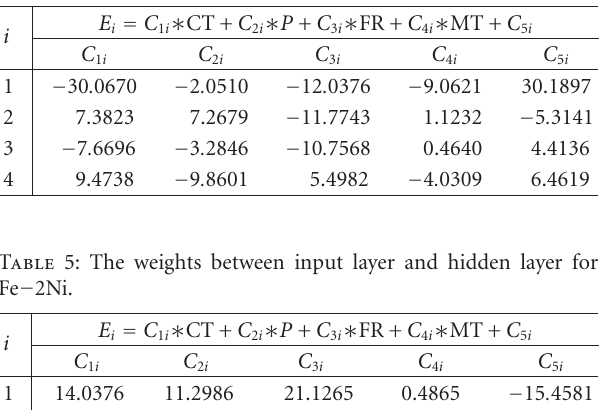
Table 4: The weights between input layer and hidden layer for FN02.